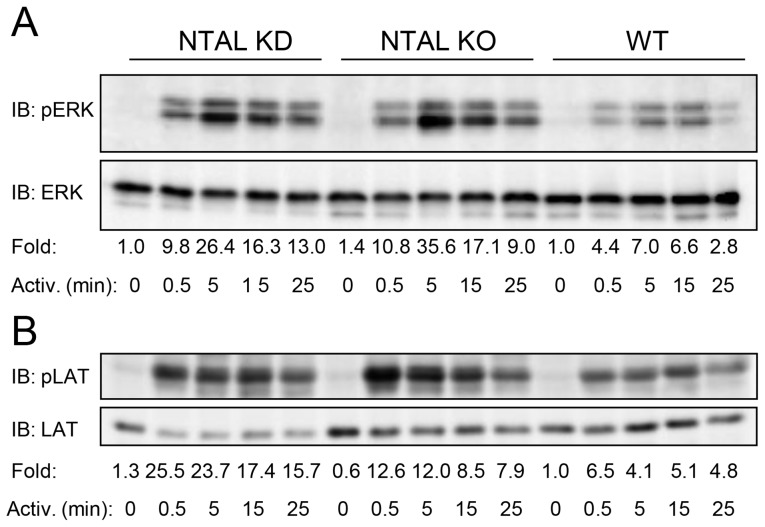
FcεRI-activated BMMCs with NTAL KD show enhanced tyrosine phosphorylation of ERK and LAT.NTAL-deficient cells and WT controls were sensitized with IgE and stimulated with Ag (100 ng/ml TNP-BSA). After the indicated time intervals, the cells were solubilized in lysis buffer and postnuclear supernatants were analyzed by immunoblotting for tyrosine phosphorylated ERK (pERK; A) or LAT (pLAT; B), followed by stripping and immunoblotting for total ERK (A) or LAT (B). Fold inductions of protein tyrosine phosphorylation, normalized to nonactivated WT cells and corrected for the amount of protein in each lysate, are also included. Each immunoblot is a typical result from three independent experiments.